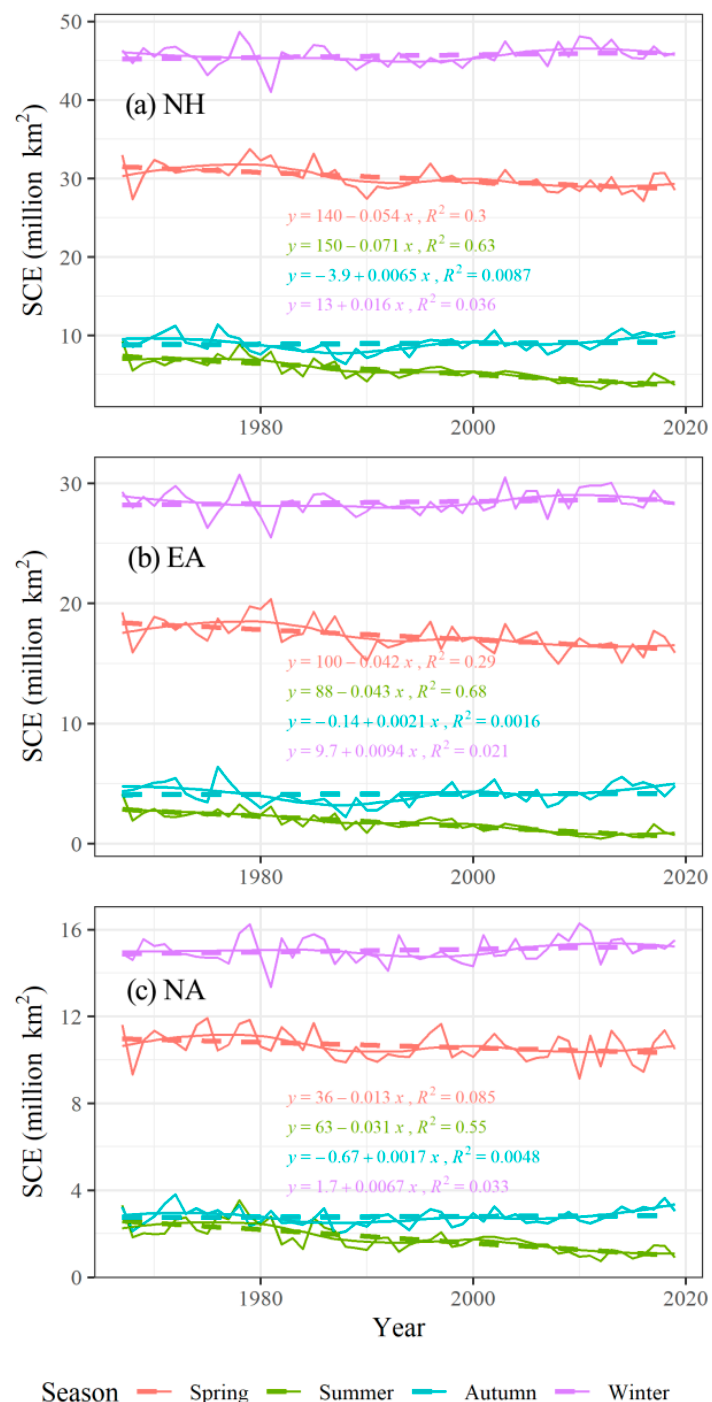
Figure 3. Variability in seasonal SCE of NH ( a ), EA ( b ), and NA ( c ) during the 1967–2018 period, with 10-year LOESS-smoothed values. Equations in the figure are for fitted linear regressions (dashed lines). .